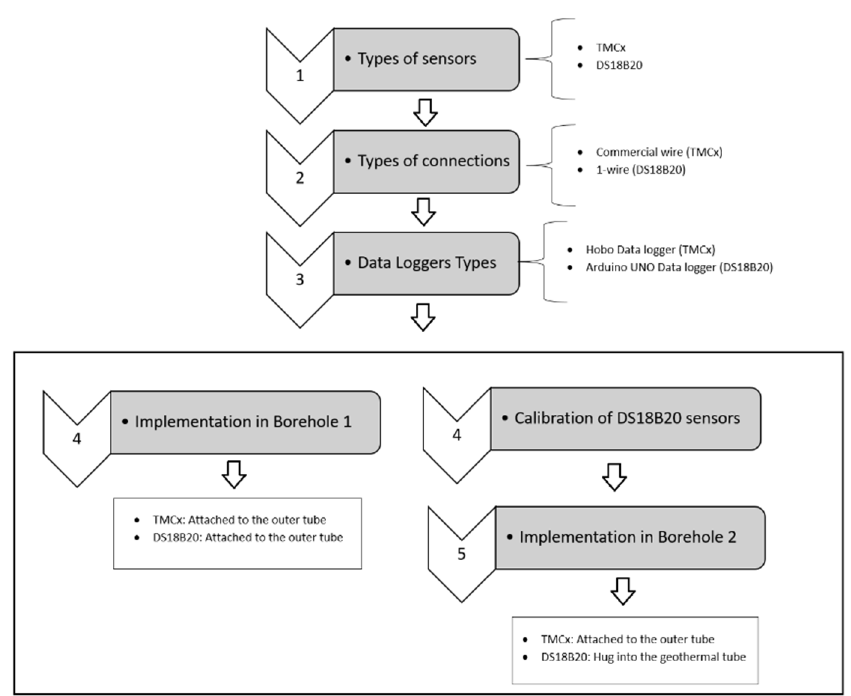
Figure 1. Flow chart.